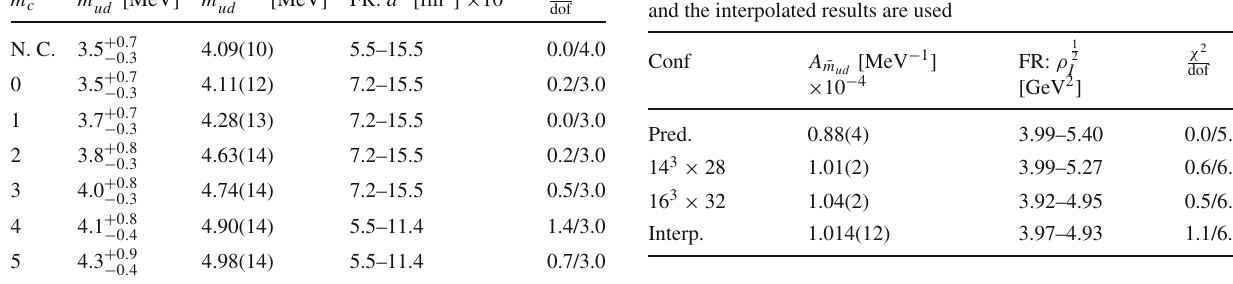
ure, the black full, the red full, and the red dashed lines indicate the ud fitting results of the predictions, the numerical results of V = 14 3 × 28, and V = 16 3 × 32, respectively. In the right figure, the black full line and the red full line indicate the fitting results of the prediction and the . In the left fig- ud interpolated results, respectively